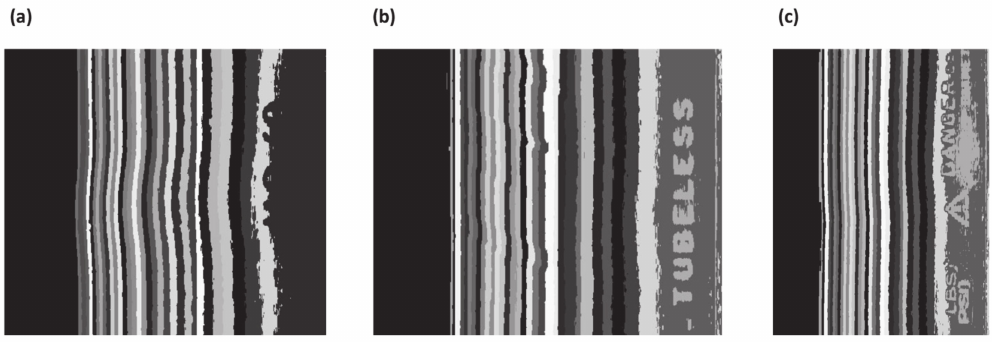
Figure 8. K-Means image processing of a homogenous region with di ff erent K cluster number.